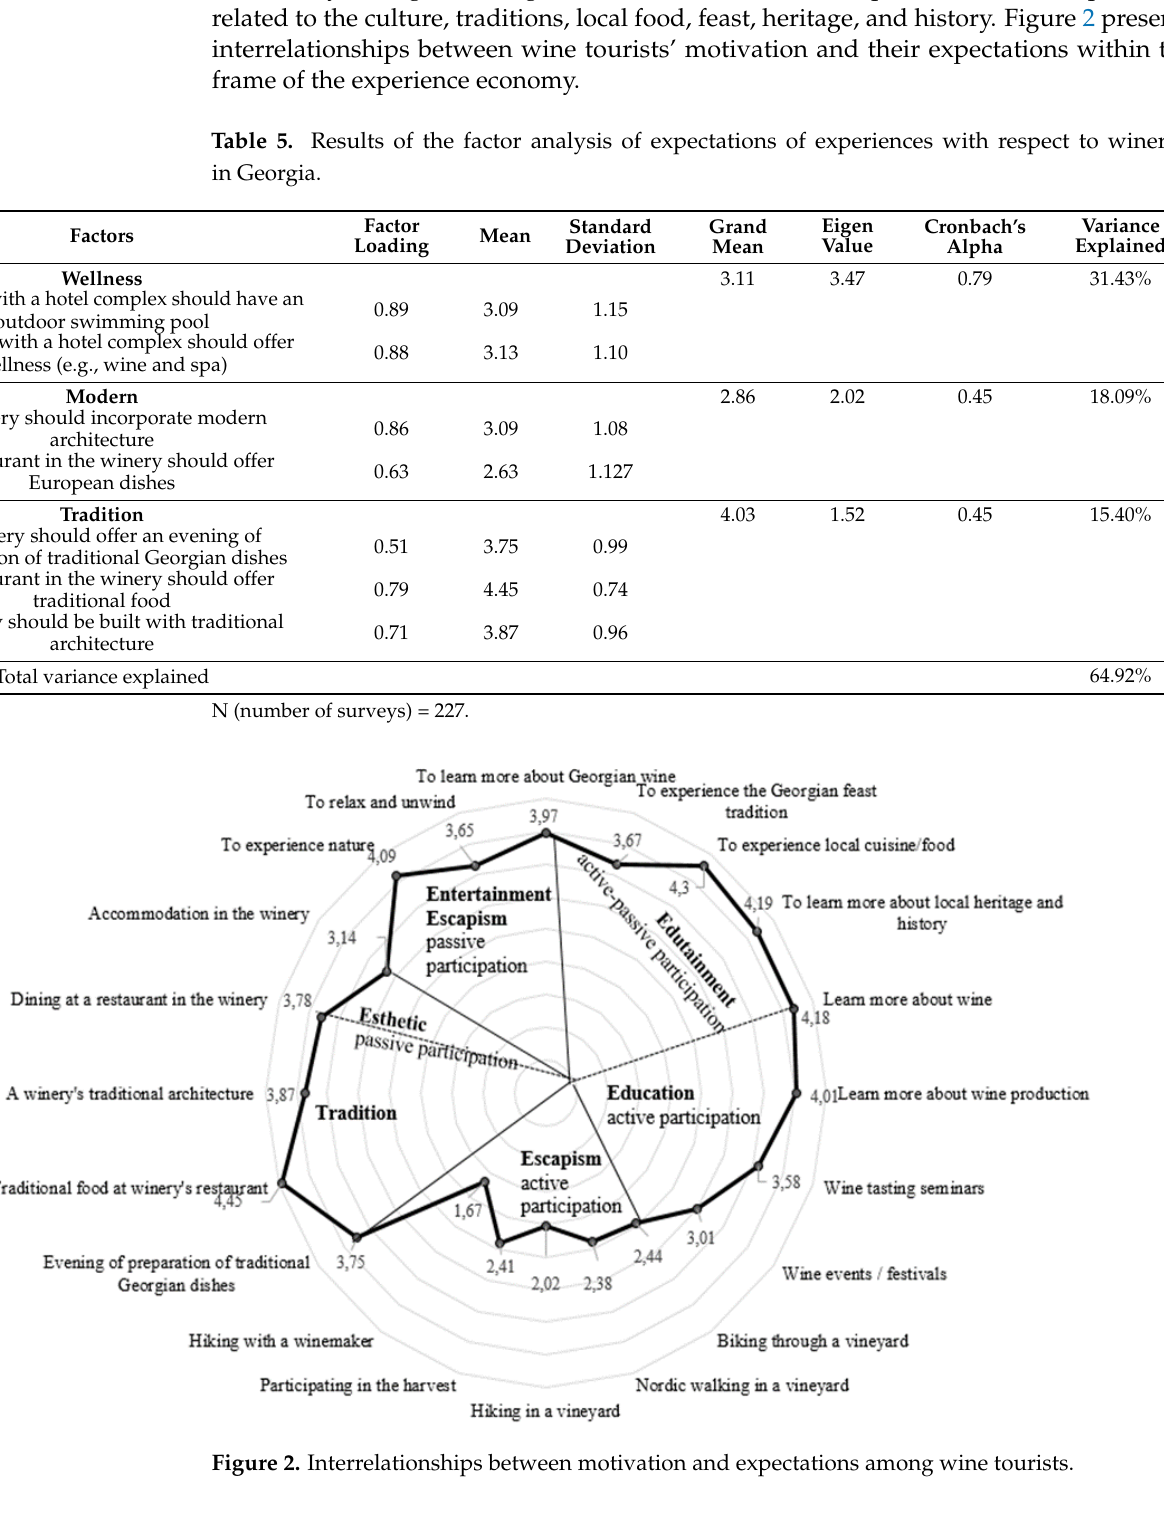
Table 5. Results of the factor analysis of expectations of experiences with respect to wineries in Georgia.